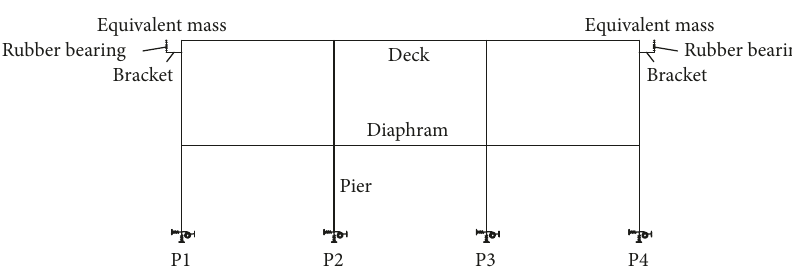
Figure 15: Seismic computational model of an RC rigid frame. Table 11: Pier bottom internal forces under low-level earthquakes.